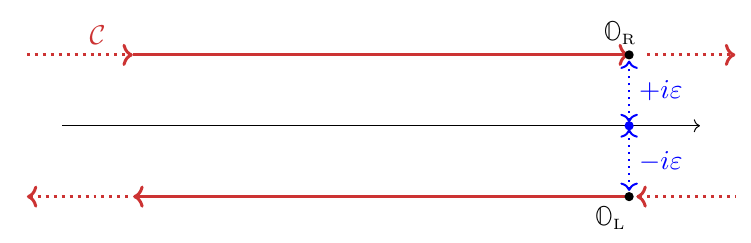
Figure 1 . Illustration of the generic Schwinger-Keldysh complex time contour. Every operator b O in the original theory has two representations in the Schwinger-Keldysh path integral, viz., O R and O , which can be thought of as the distinction as to what part of the contour the operator is L inserted on. Right operators are time-ordered, while left operators are anti-time ordered.